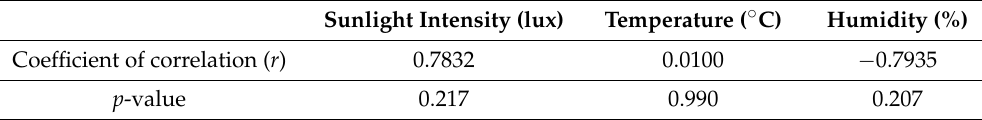
Table 5. Correlation between weather characteristics and percentage of termite infestation. Sunlight Intensity (lux) Temperature ( ˝